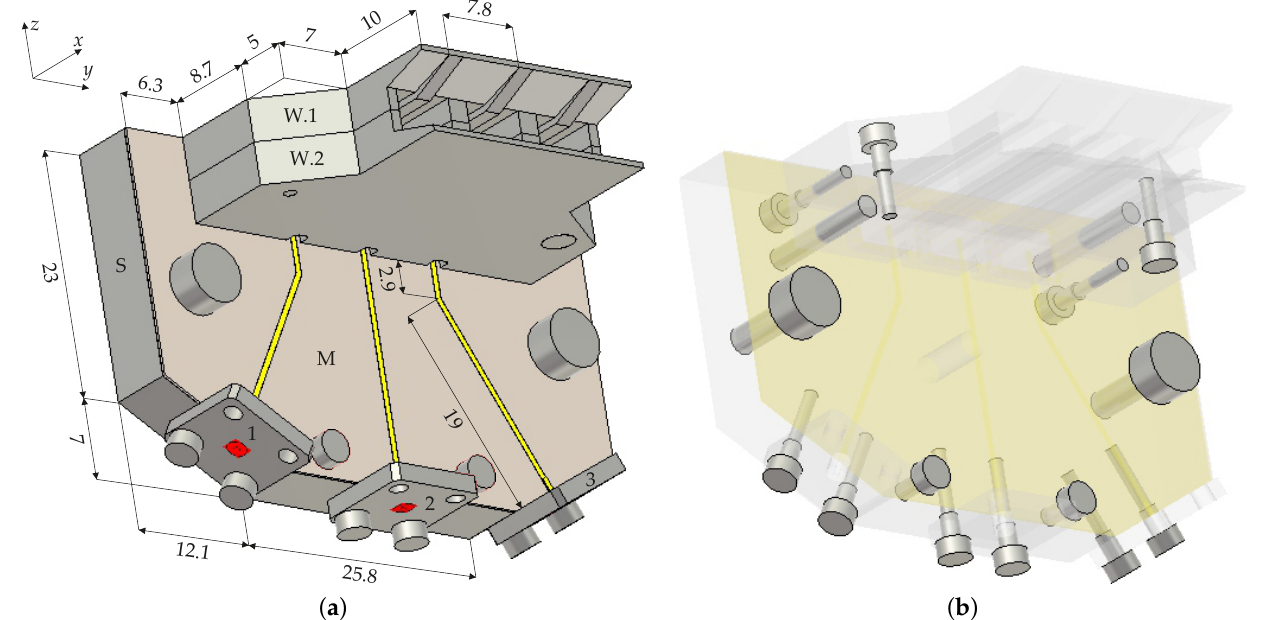
Figure 3. ( a ) Whole structure of the antenna array and ( b ) its mounting screws. Dimensions are in millimeters.